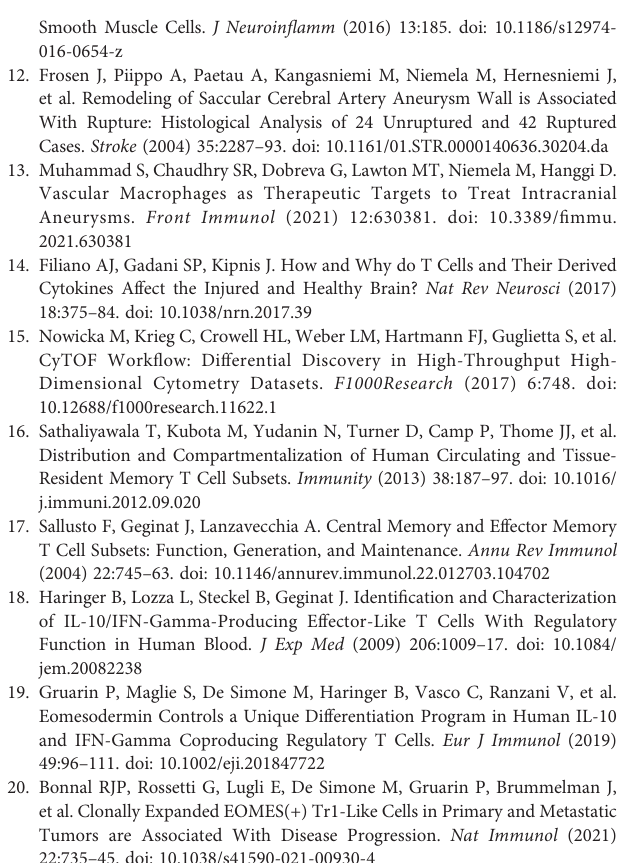
Supplementary Table 3 | MFI values of CD127, CCR5, CCR6, GZMB, GZMK, CXCR3, CD27 and CD69 expression among CD4+ T cells. Supplementary Figure 1 | (A) UMAP of cells colored according to the clusters as indicated obtained by FlowSOM using K = 20. (B) Heatmap of median normalized expression of markers within each cluster. Dendrogram on the left side of the heatmap shows similarities among clusters.